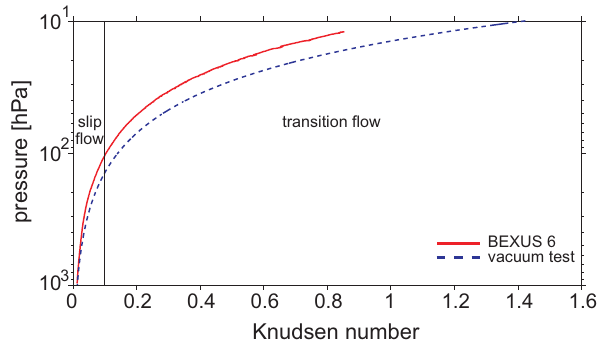
Figure 4 (bottom) raises the questions whether the sensor sensitivity decreases further at pressures below 100 hPa and whether there is a lower pressure limit for CTA